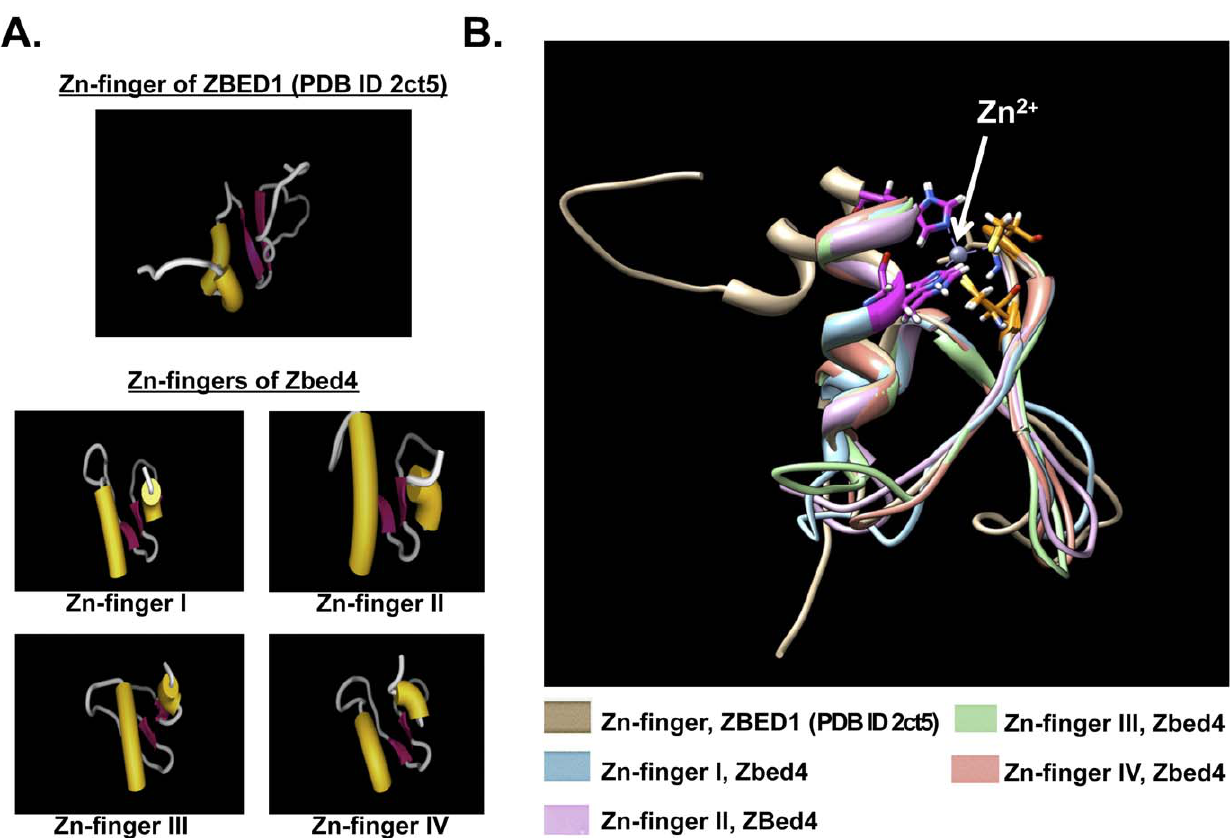
Figure 10. A. Structure modeling for BED zinc-finger (I, II, III and IV) domains of Zbed4, based on the structure of ZBED1 (PDB ID: 2ct5). The program iMol, version 0.40 and the UCSF Chimera package [39] were used to generate these models. B . Superimposed model of all predicted BED zinc-finger structures of Zbed4 (I, II, III and IV) and ZBED1 (PDB ID: 2ct5). Each finger is shown in a different color.